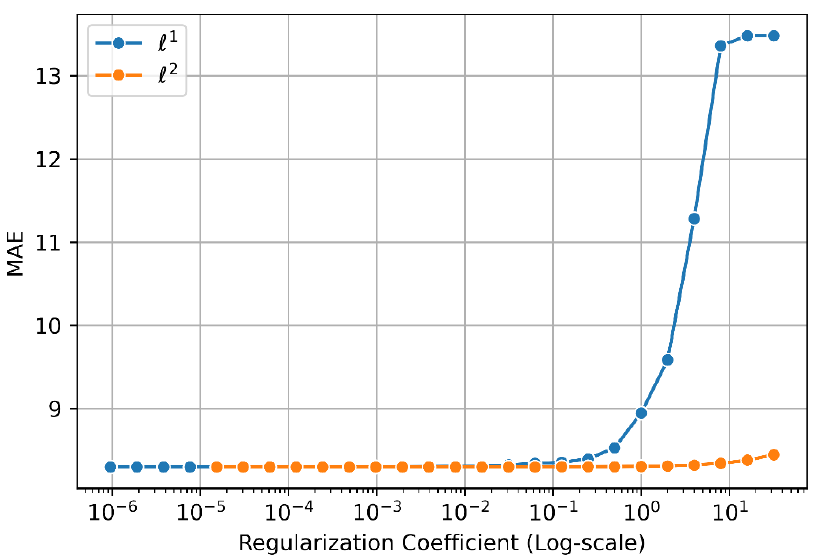
Figure 4. The effect of lasso and ridge regularization on linear regression performance.